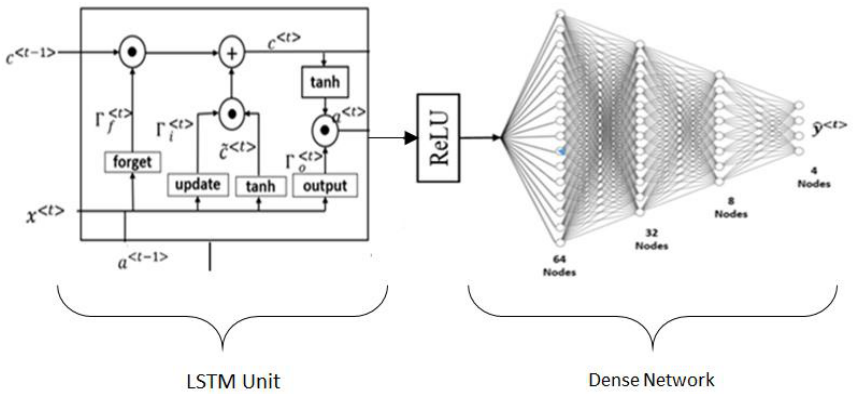
Figure 8. The basic model of LSTM architecture.